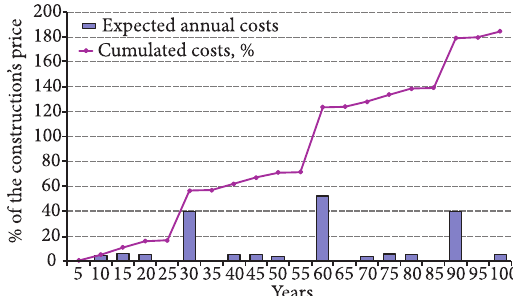
Fig. 16. Graph – repairs and maintenance costs (% of the construction’s